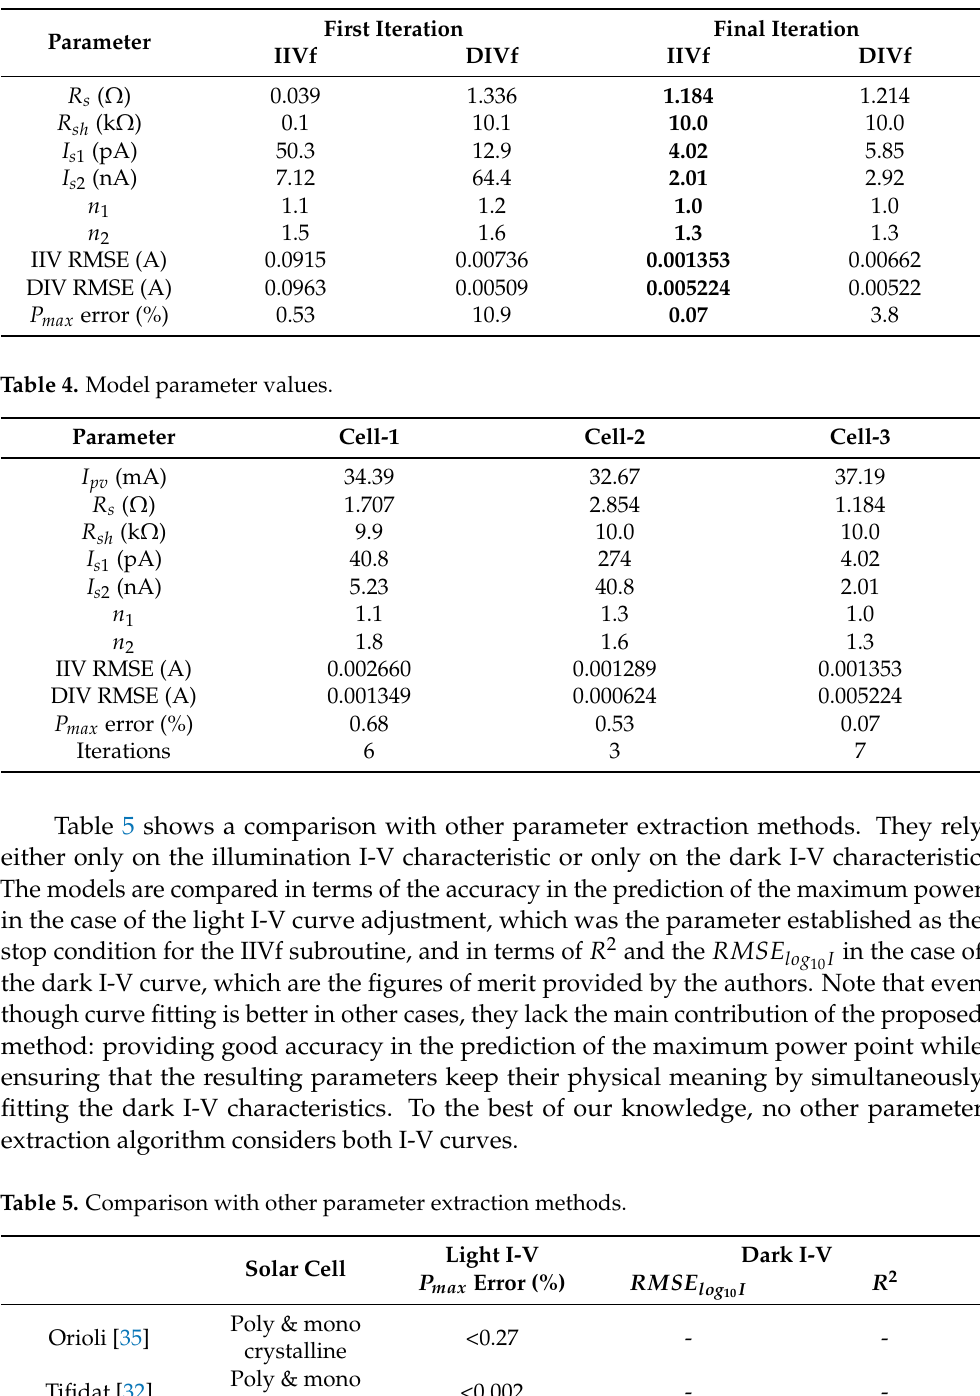
Table 3. Evolution of the extracted parameters for Cell-3.